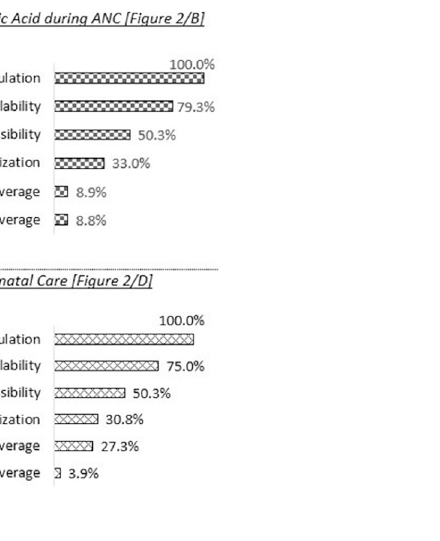
Fig 2. (A-D) Tanahashi framework analysis for ANC, Delivery care, and